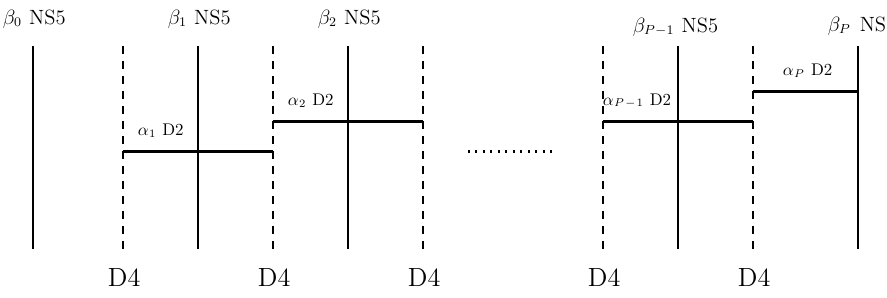
Figure 5 . Brane set-up associated to the quantised charges (4.16)–(4.18), in units of q